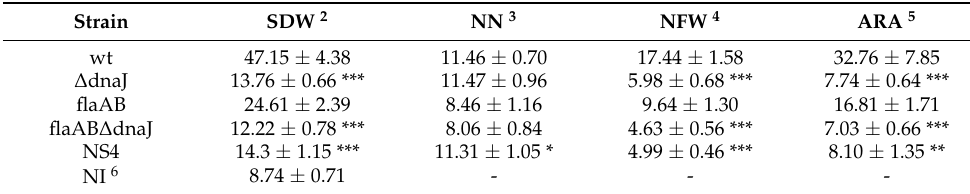
Table 2. Symbiotic parameters of alfalfa plants inoculated with S. meliloti wild-type, flaAB mutant, and dnaJ derivative mutant strains 1 .